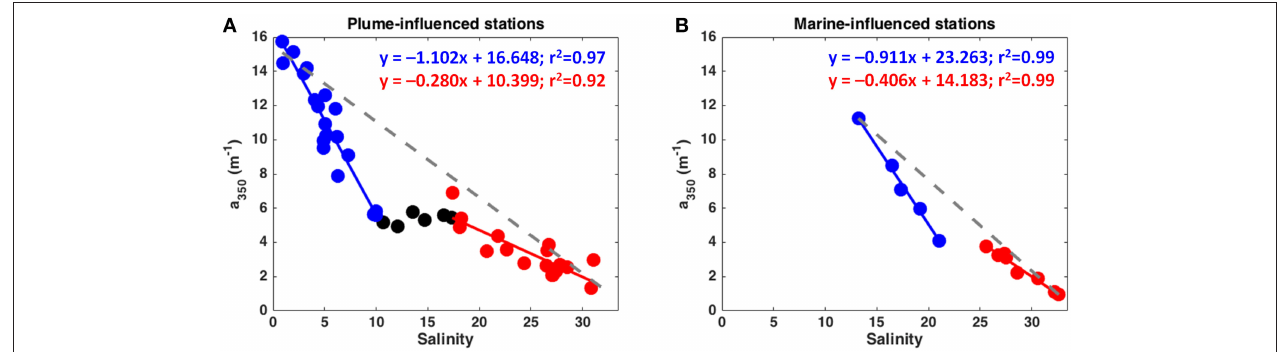
FIGURE 3 | a 350 against salinity plot for the Plume-influenced (A) and Marine-influenced (B) stations. Samples above the pycnocline are displayed in blue whereas the ones below it are presented in red. Samples located at the pycnocline are displayed in black. All the fits presented in this figure are significant ( p < 0.0001 ). Gray dashed-lines indicate the hypothetical conservative mixing line between DOM and salinity for each of the plots.